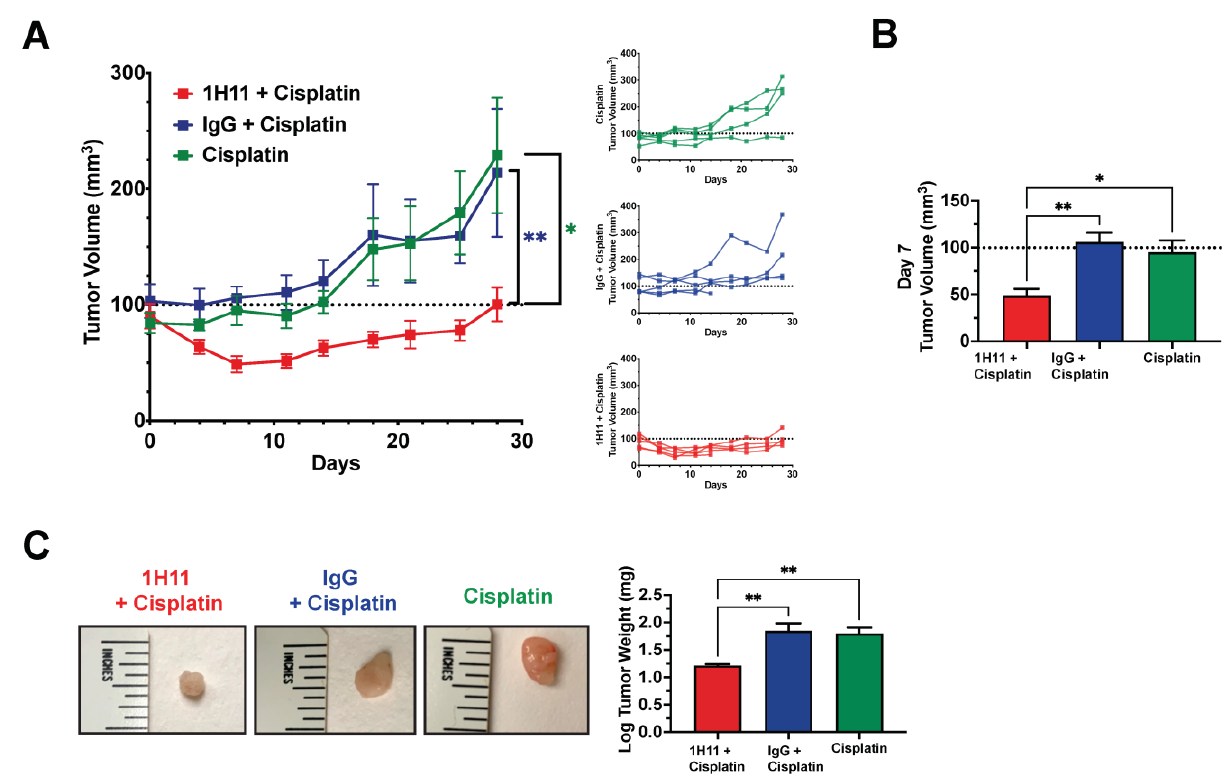
Figure 9. 1H11 enhances sensitivity to cisplatin in vivo. Athymic nude mice with OVCAR8 subcutaneous tumors were administered either dual treatment of (1) 1 mg/kg 1H11 and 2 mg/kg cisplatin, (2) 1 mg/kg IgG, and 2 mg/kg cisplatin, or (3) 2 mg/kg cisplatin alone for up to 28 days. ( A ) Average and individual mouse tumor volume curves throughout treatment. ( B ) Tumor volume at day 7 of treatment. ( C ) Tumor weights at the end of the study and representative images of tumors. All data plotted as mean ± SEM. ** p < 0.01, * p < 0.05 vs. 1H11 + Cisplatin.